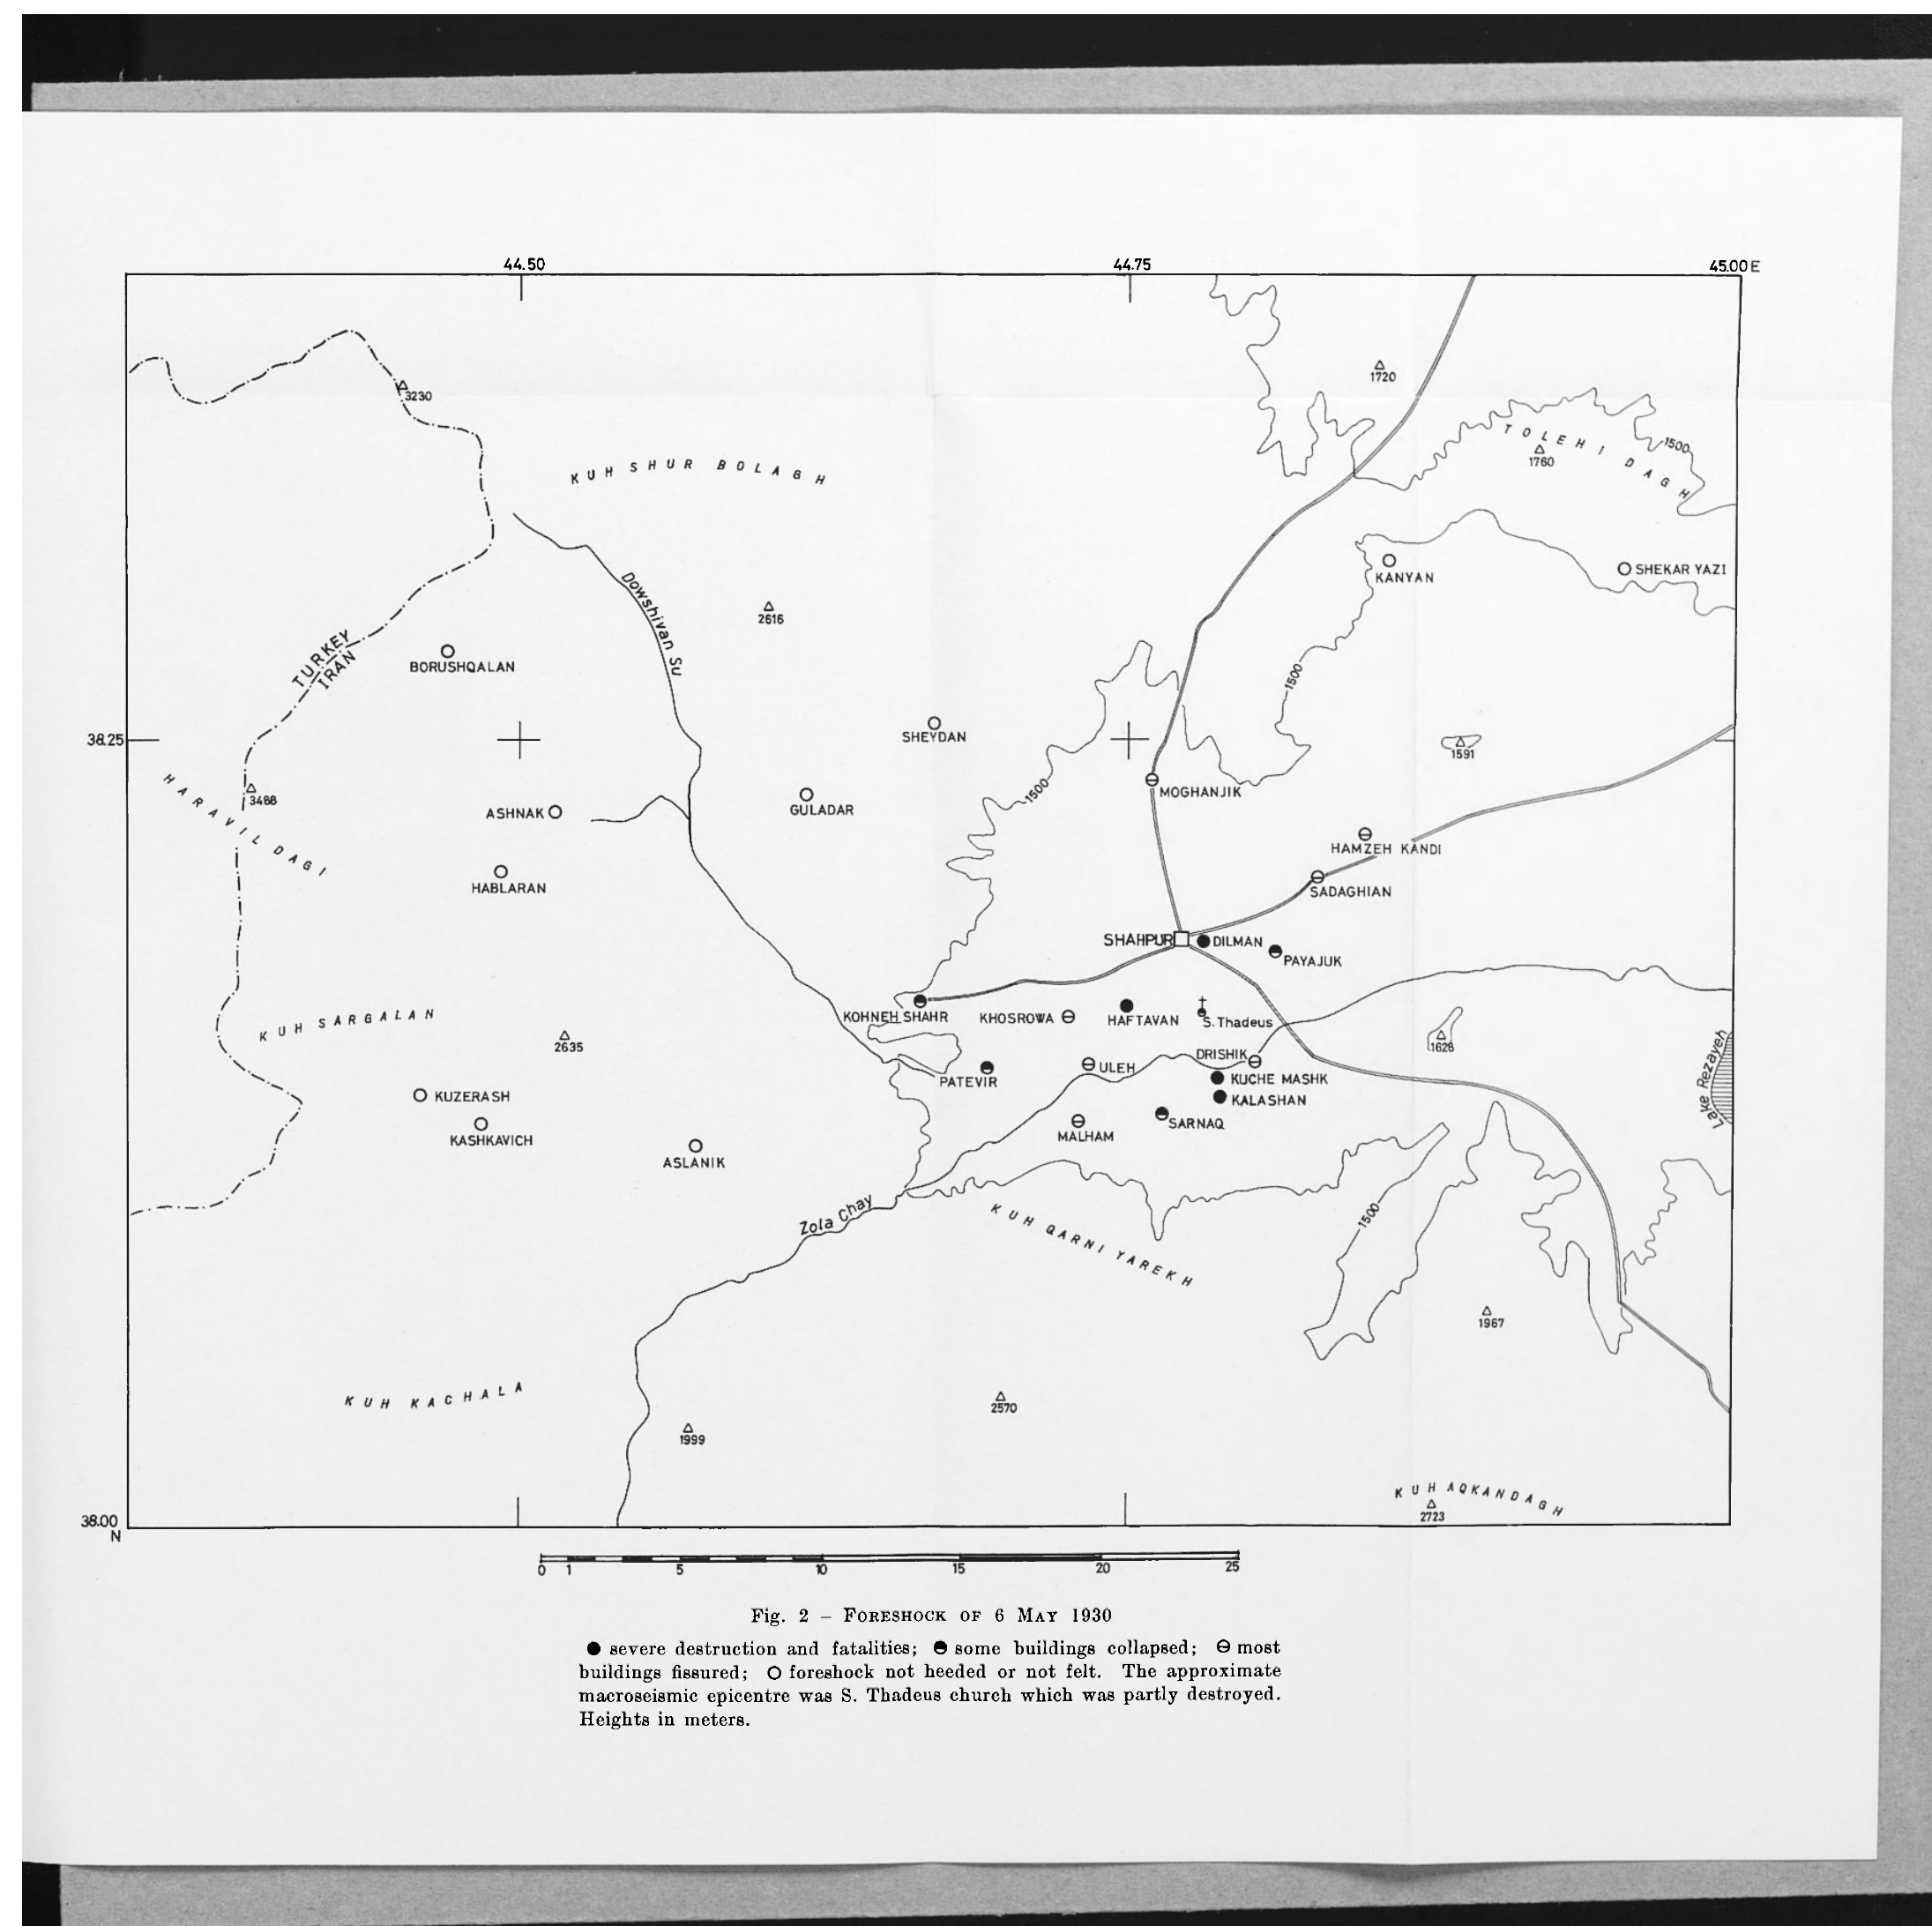
Fig. 2 - FORESHOCK OF 6 MAY 1930 • severe destruction and fatalities; ® some buildings collapsed; © most buildings fissured; O foreshock not heeded or not felt. The approximate macroseismic epicentre was S. Thadeus church which was partly destroyed. Heights in